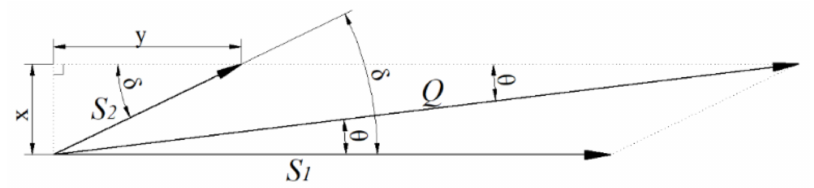
Figure 2. Scheme for calculating the inclination angle θ of the resultant force vector Q .